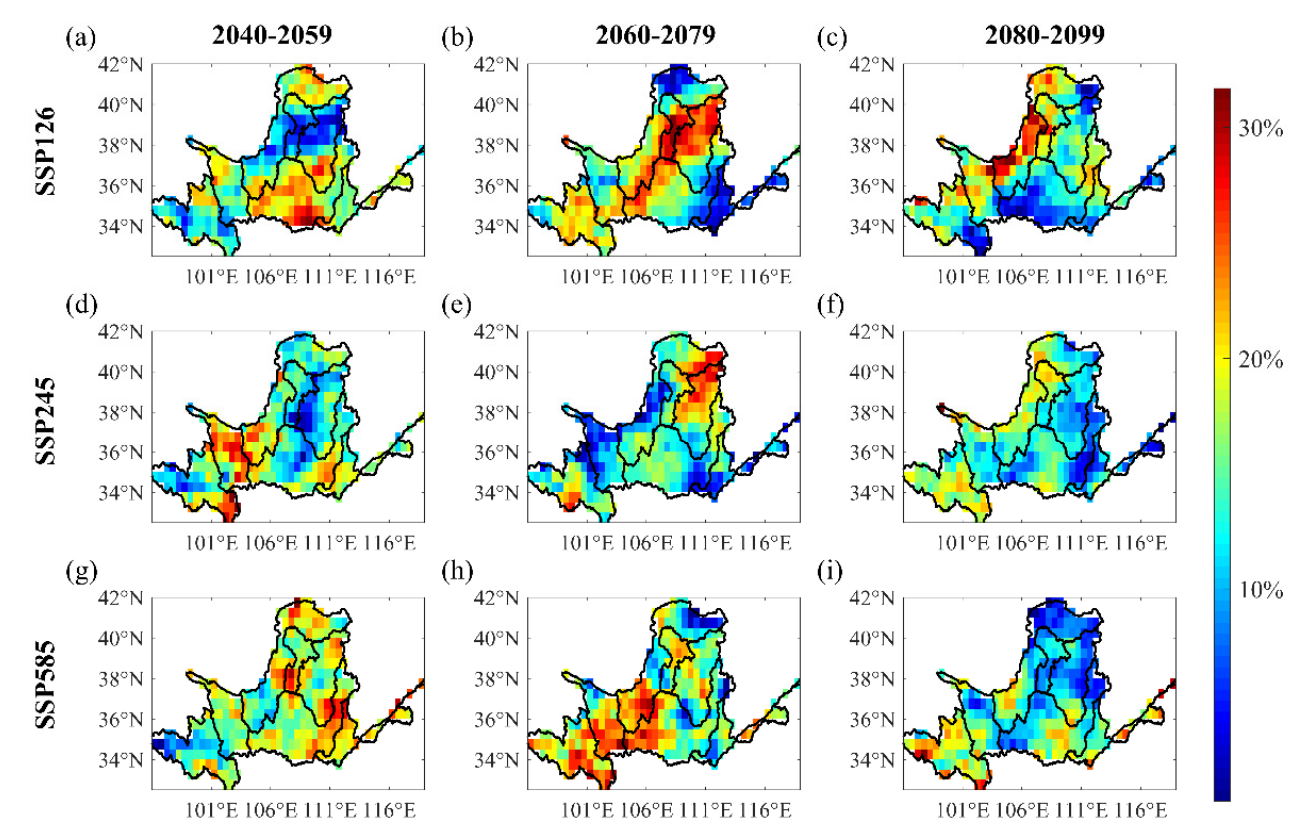
Figure 9. Spatial distribution of drought frequency from SSP126, SSP245, and SSP585 over 2040–2099 in the Yellow River basin. ( a – c ) are the drought frequency of near future, middle future, far future under SSP126, ( d – f ) are the drought frequency of near future, middle future, far future under SSP245, ( g – i ) are the drought frequency of near future, middle future, far future under SSP585.